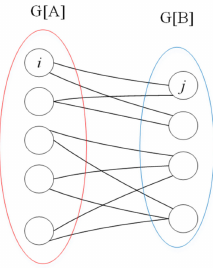
Figure 11. An agreement graph, G = ( A ∪ B,E ), that is also a bipartite graph in which agreeing jobs are connected by